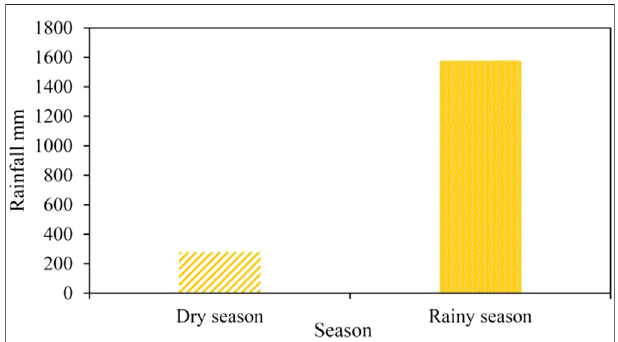
FIGURE 6 | Rainfall during the dry and rainy seasons in Xincun Bay. Rainy season was from May to October in 2020, and dry season was from November in 2020 to April of the following year (data from http://www.